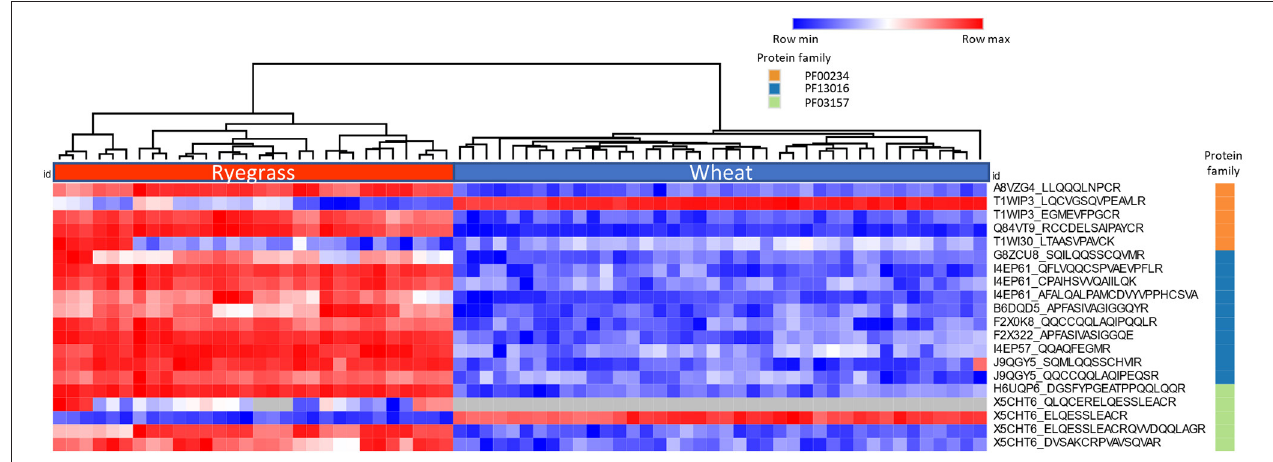
FIGURE 2 | The Heatmap and hierarchical clustering show the relative abundance of the peptides representing two major groups detected across 10 ryegrass cultivars ( n = 3) and 10 wheat cultivars ( n = 4). The colour in each cell represents the log (peak area) of each peptide monitored (red = max value, blue = min value, grey = NA). The column to the right indicates the protein family membership for the peptides (orange = PF00234-Tryp_alpha_amyl family, blue = PF13016-Gliadin, green = PF03157-Glutenin_HMW).